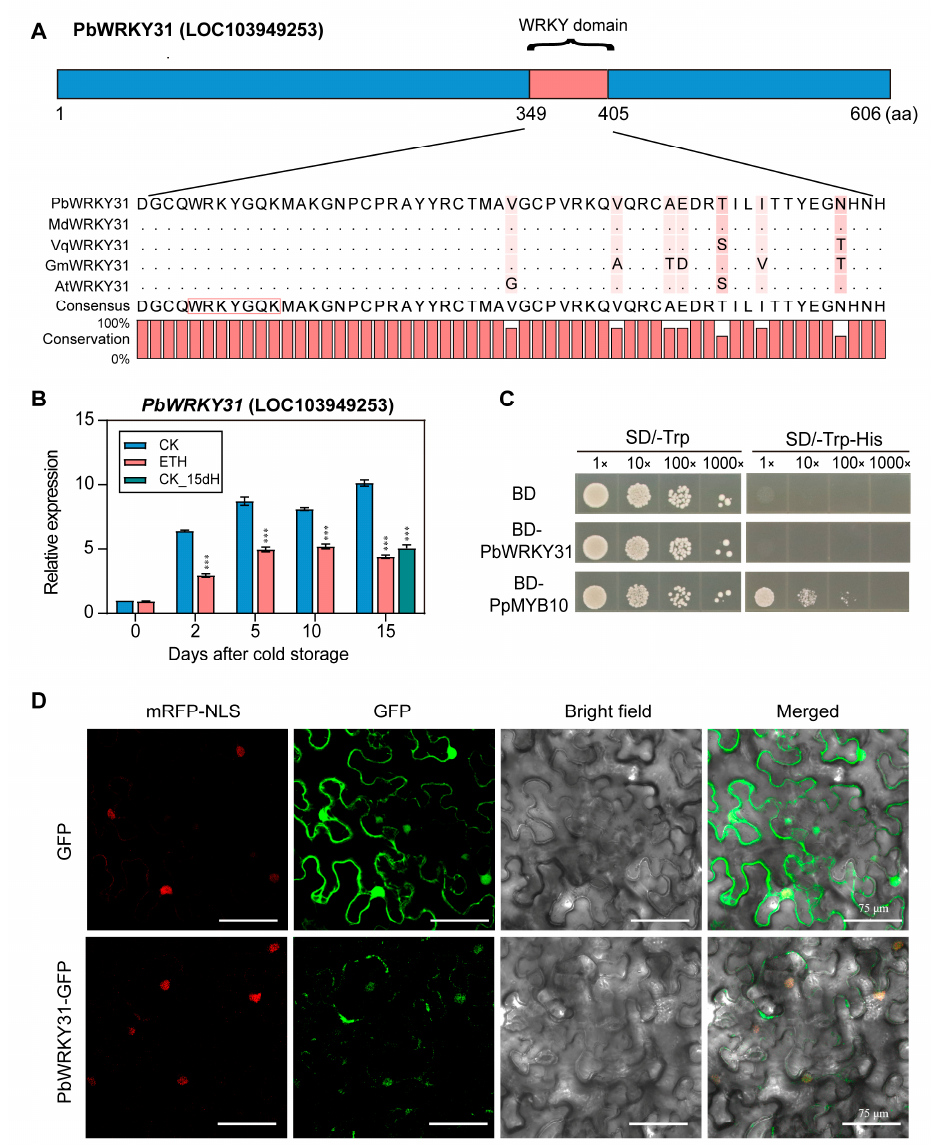
Figure 8. Sequence conservation, gene expression, transcriptional activation, and subcellular localization of PbWRKY31. ( A ) Conserved sequence analysis of the WRKY domain of PbWRKY31 with those of WRKY31 from other species. MdWRKY31 (apple): MD05G1349800; VqWRKY31 (grapevine): VIT_10s0116g01200; GmWRKY31 (soybean): XP_003546160.1; AtWRKY31 ( Arabidopsis ): AT4G22070. The WRKYGQK motif is marked with a red rectangle. ( B ) Validation of PbWRKY31 expression via a RT-qPCR. All data are mean ± standard deviation from three biological replicates. Asterisks indicate significant differences (*** p < 0.001) as calculated using two-tailed Student’s t - test within each time point. ( C ) Transcriptional activation of PbWRKY31 in the yeast. The GAL4 DNA-binding domain ( B , D ) and BD-PpMYB10 were used as the negative and positive control, respectively. SD/-Trp, synthetic dextrose medium lacking Trp; SD/-Trp-His, synthetic dextrose medium lacking both Trp and His. The transformed yeast cells were diluted at 1, 10, 100, and 1000-fold for dropping on the selective plates. ( D ) Subcellular localization of PbWRKY31 in Nicotiana benthamiana leaf cells. Scale bar: 75 μ m. mRFP-NLS is a nucleus marker.